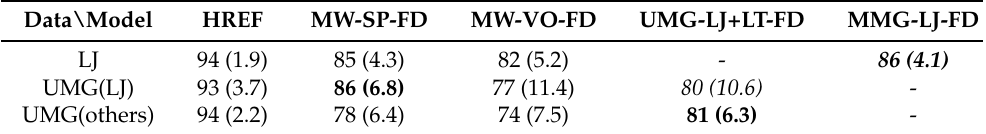
Table 4. Average rating and standard deviation for the perceptual evaluation of the perceived difference between original and resynthesis for the speech and all-purpose variants of the MBExWN model. The test data is taken from data sets containing voice identities that where never seen by the MBExWN models. For the base line models UMG-LJ+LT-FD and MMG-LJ-FD the voice identity LJ was part of the training data